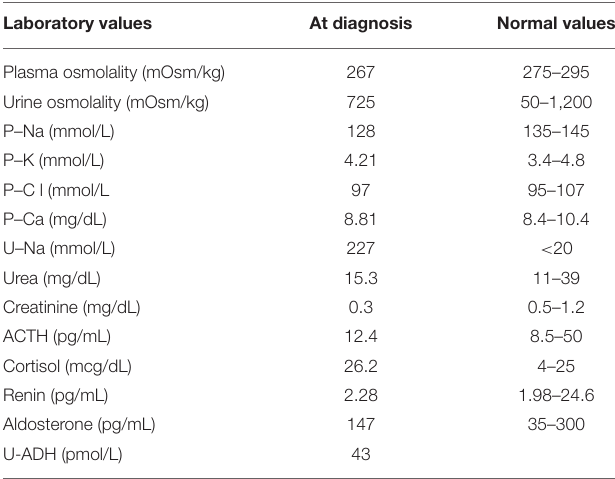
TABLE 1 | Patient’s laboratory values, obtained after initial correction of 3% salts, 2 mL/kg delivered as bolus, at SIADH diagnosis. Laboratory values At diagnosis Normal